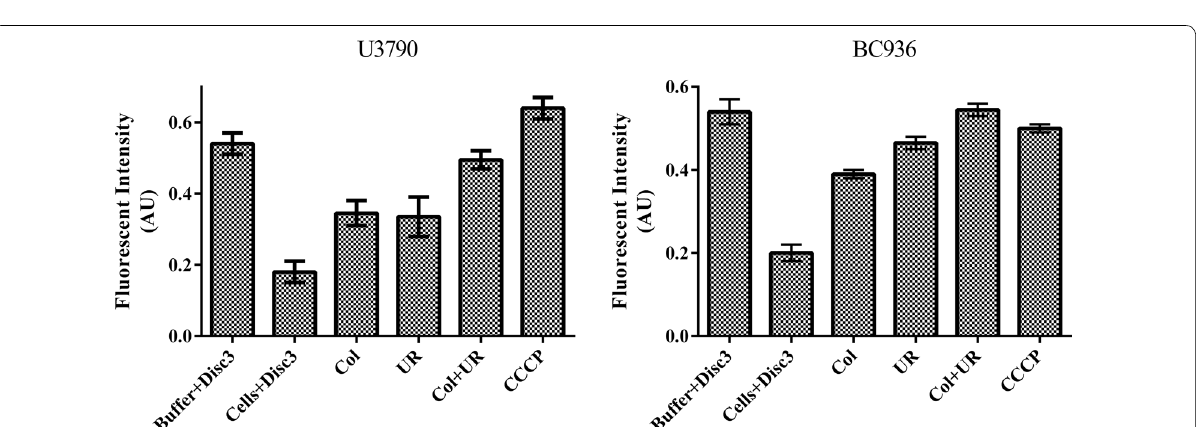
Fig. 5 Ursolic acid with colistin causes effective membrane depolarization in E. coli U3790 and K. pneumoniae BC936. Mid log cells of U3790 and BC936 were treated with colistin (Col), ursolic acid (UR) and colistin measured at Ex 605 nm and Em 665